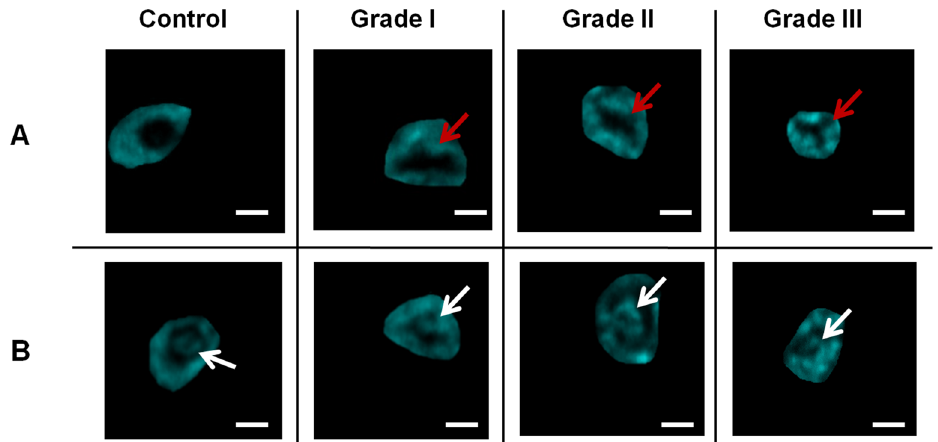
Figure 3. THG images of representative cells (from benign tissue left column and grades I, II and III of cancer at the following columns) showing irregularities in the nucleus ( A ) and nucleoli ( B ). Red arrows depict the irregular nucleus (shown as black area) in ( A ) and white arrows indicate nucleoli located within the nuclear area (interface of nucleus and nucleoli) in ( B ). Scale bar depicts 2